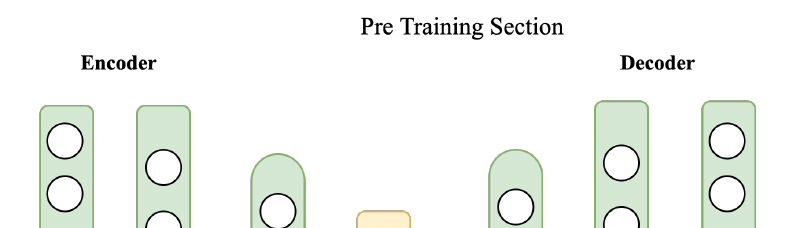
Figure 3. The model of an autoencoder.